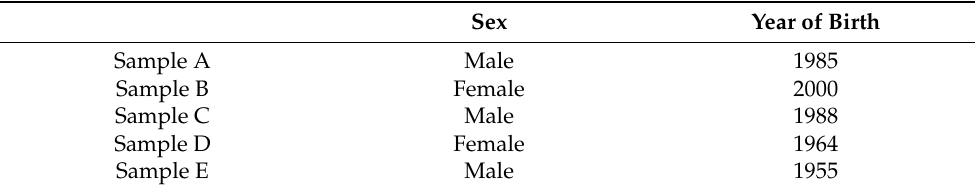
Table 1. Basic information of blood